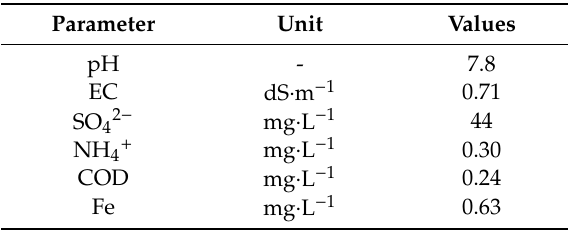
Table A1. Water quality of the irrigation water. EC: Electrical conductivity; SO 42 − : sulfate; NH 4 + : ammonium; COD: chemical oxygen demand; Fe: